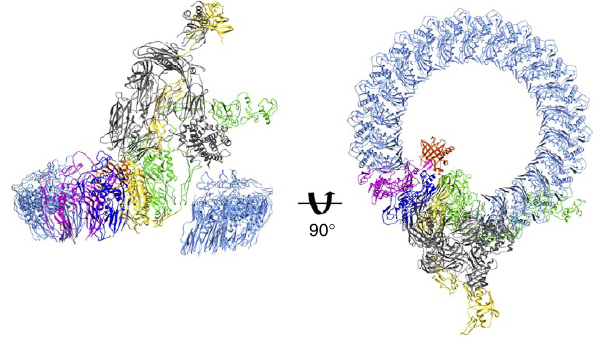
Figure 4 | MAC is an asymmetric pore. Pseudo-atomic model of the MAC CDC/MACPF rim, including C5b. Complement proteins coloured as in Fig. epidermal growth factor (EGF) modules encircle its base (Figs 2b